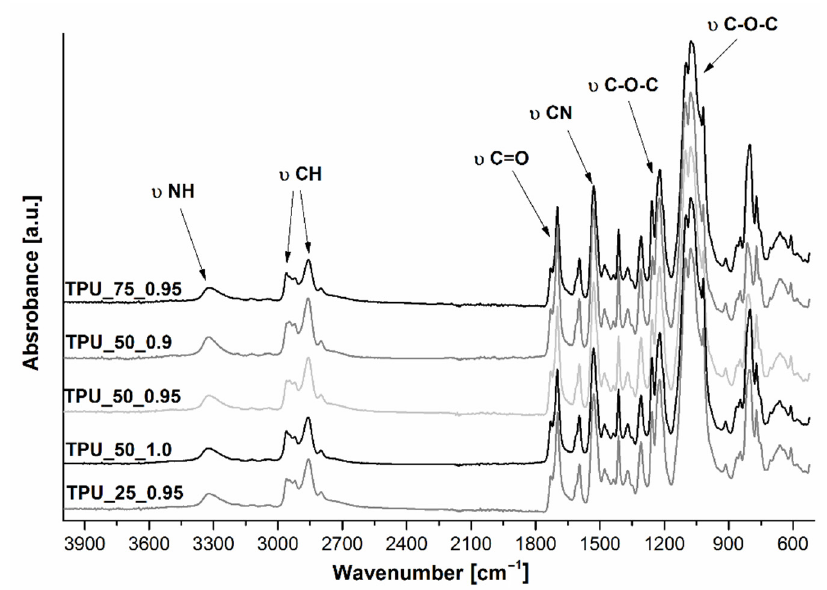
Figure 2. FTIR spectra of prepared green TPUs.